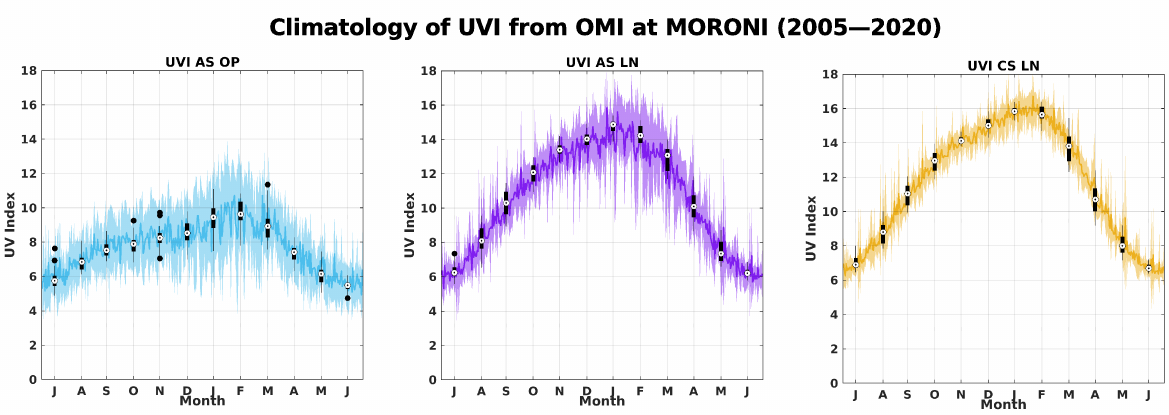
Figure 2. Monthly Climatology of UVI from OMI. Black box diagrams for each month are centered on 15th day of month. Median is central value, box edges are set at 25 th and 75 th percentiles, whiskers show extreme values, excluding outliers, which are represented by single black circles. Blue, purple, and yellow lines show mean for each day of year, and blue and yellow shading shows one standard deviation. Months on X-axis were reorganized to highlight austral summer. Blue color denotes UVI-OMI-AS, and yellow color denotes